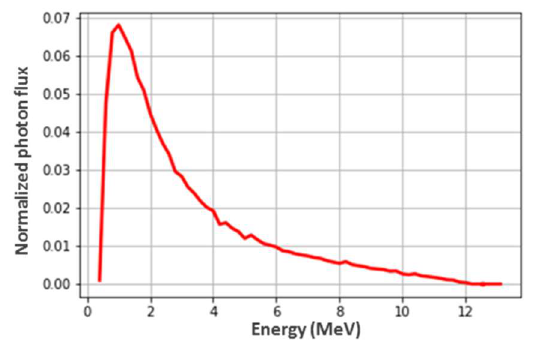
Fig. 2. Energy spectrum obtained by Monte-Carlo simulation of the SATURNE accelerator, for monoenergetic electrons of 12 MeV. Some work has proposed the use of a continuous model where these changes can be represented by a lognormal function [5]. Then, the energy spectrum can be estimated from the lognormal function equation in discrete form for the different energy channels via